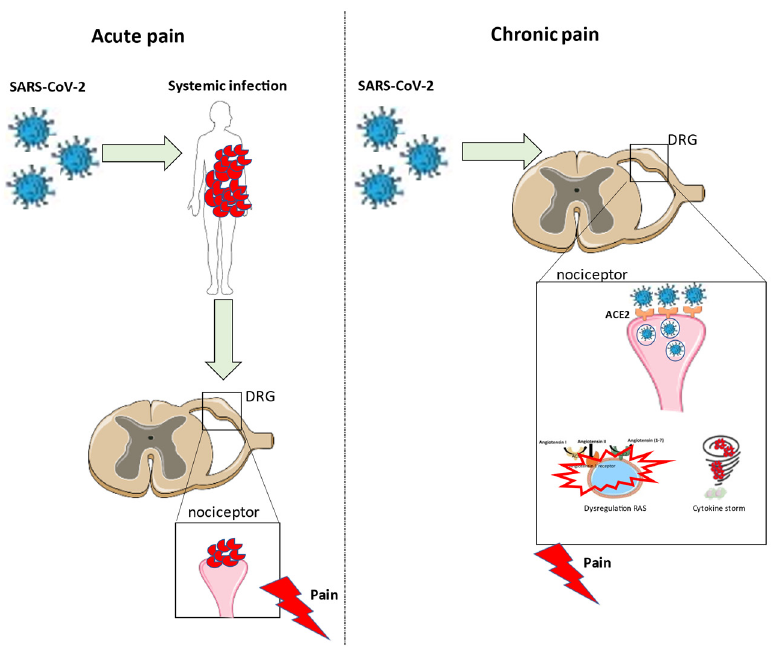
Figure 3. Overview of the development of acute and chronic pain after a SARS-CoV-2 infection.